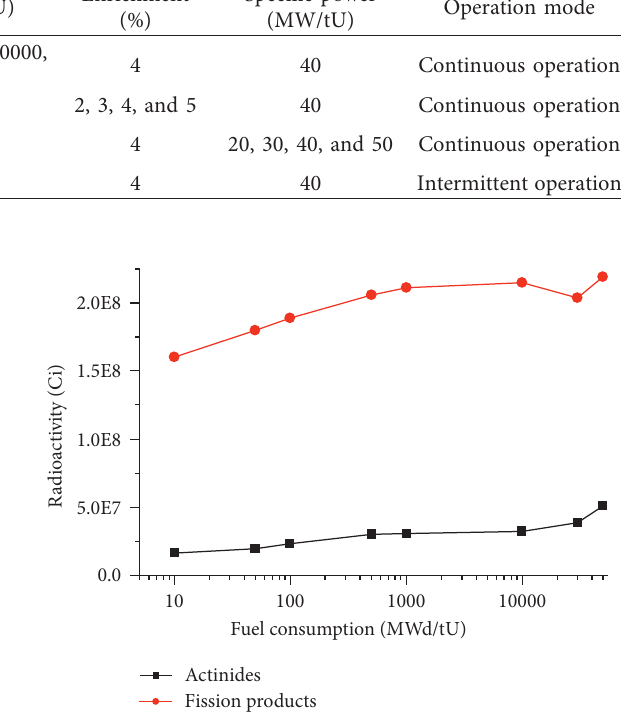
Figure 1: The radioactivity of actinides and fission products under different fuel